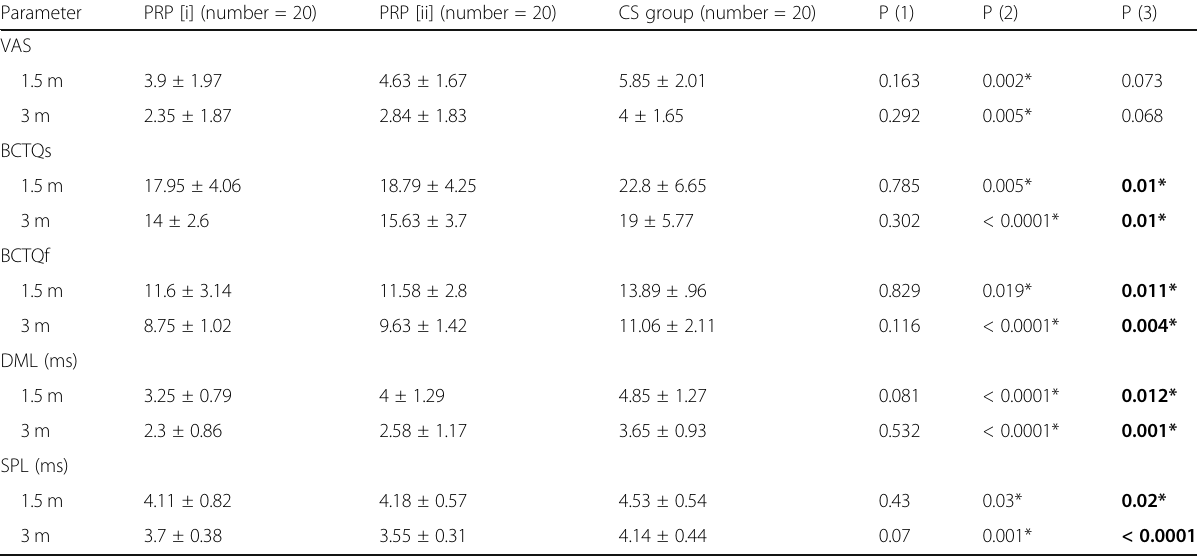
Table 2 Outcome variables at 1.5 and 3 months of follow-up in the PRP and control groups Parameter PRP [i] (number =